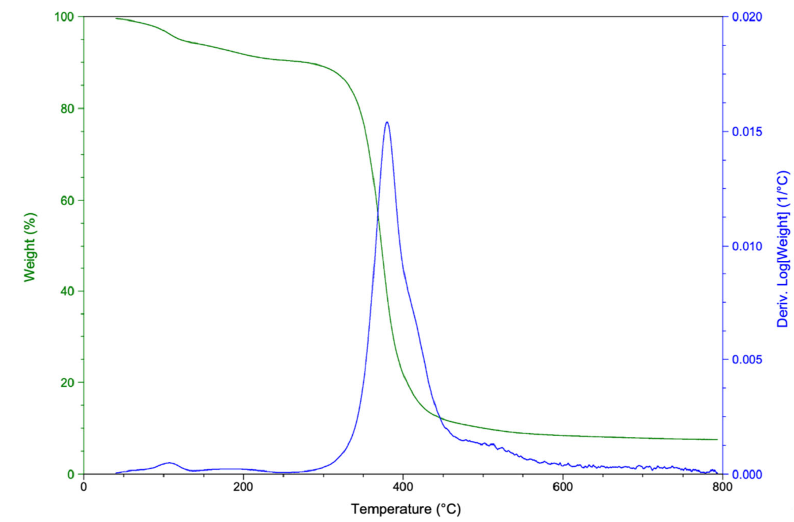
Figure 9. TGA (green curve) and DTG (blue curve) thermograms of rTP–II.